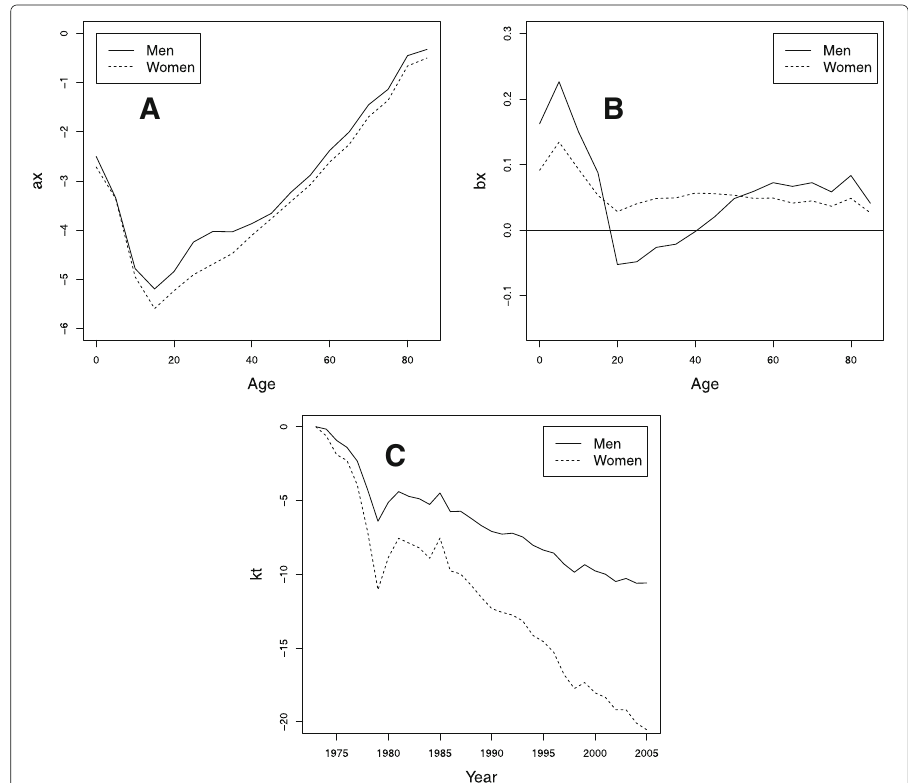
Fig. 5 Parameters for the LC model fitted to the Colombian data for the period 1973–2005, men (solid line) and women (dotted line). a a x . b b x . c k t